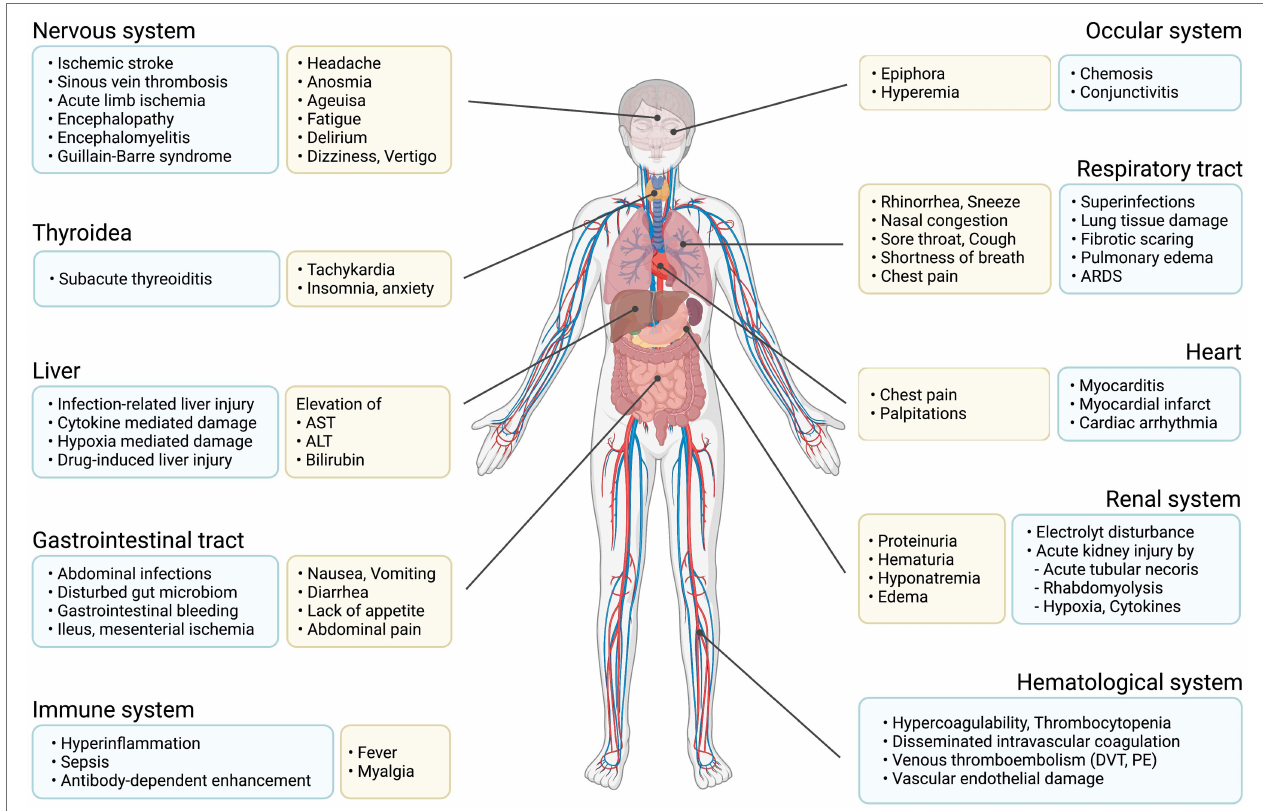
FIGURE 2 | Main organ complications due to COVID-19. Graphical representation of possible symptoms and organ damage caused by